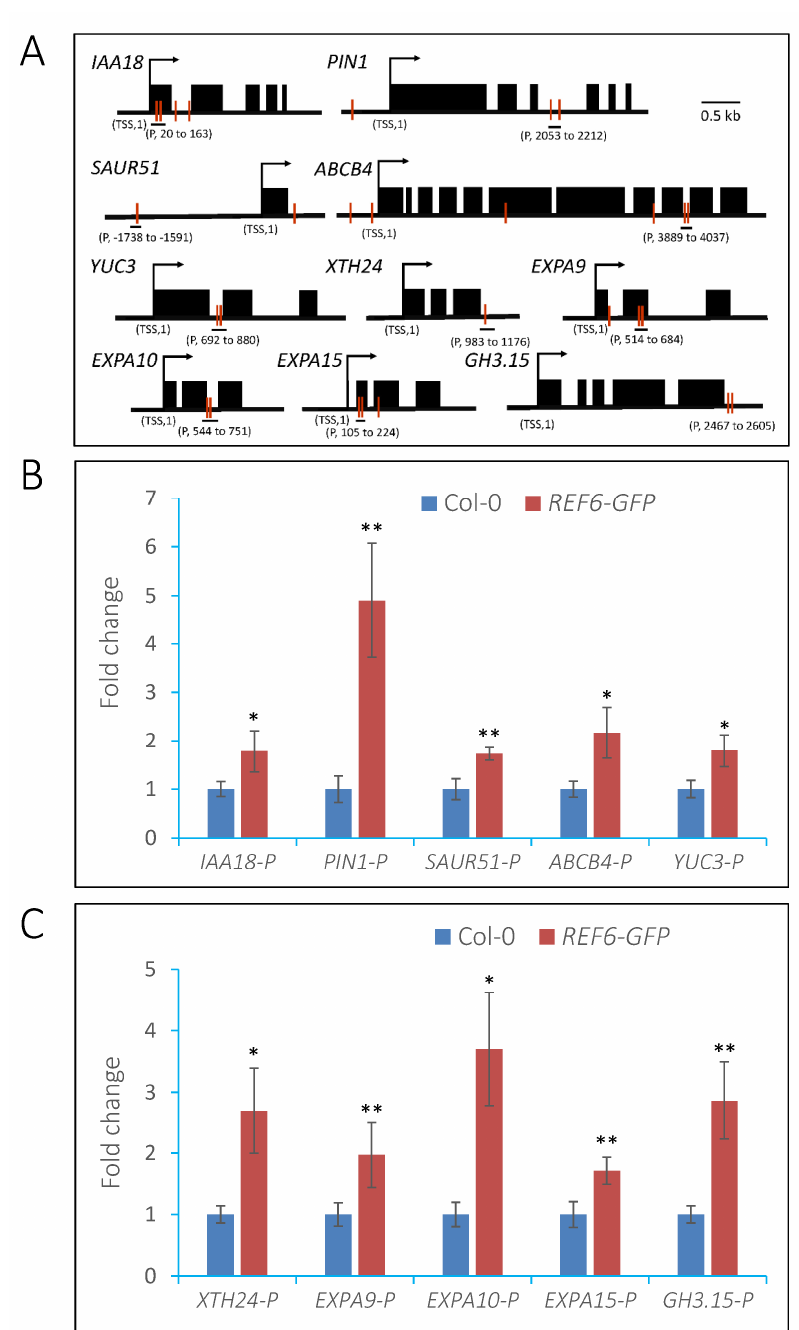
Figure 8. REF6 targets auxin-signaling and cell-wall-loosening-related genes under FR/R conditions. ( A ) Schematic diagram of the regions for ChIP analysis. The red lines indicate the CTCTGYTY motifs. TSS, transcription start site. The “P” regions were selected for analysis. ( B ) ChIP-qPCR analysis of enrichment of REF6 in auxin-signaling-related genes. ( C ) ChIP-qPCR analysis of enrichment of REF6 in cell-wall-loosening-related genes. After FR/R treatment, seeds were kept in the dark for 24 h and then crosslinked. The chromatin was extracted, sheared to an average of 500 bp and then immunoprecipitated with anti-GFP beads overnight. The DNA–protein complex was eluted and crosslinking was reversed. The immunoprecipitated DNA was extracted for qPCR analysis. The fold enrichment was normalized to the internal control ACTIN2 . Values are shown as means ± SD ( t -test, * p < 0.05, ** p < 0.01, n =